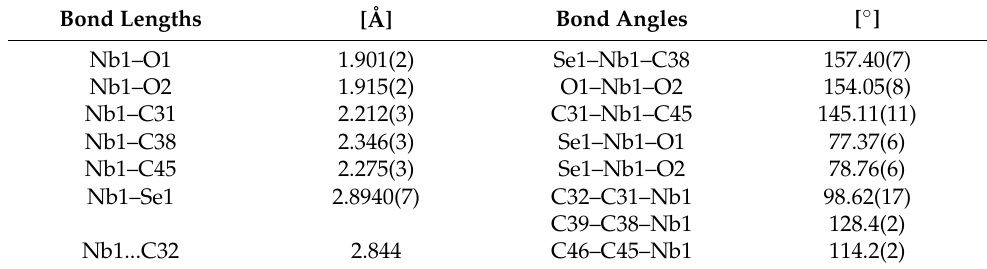
Figure 2. The ORTEP of mer - 6 with thermal ellipsoids at 50% probability. All hydrogen atoms and a molecule of hexane in the unit cell are omitted for clarity. Table 2. Selected bond lengths [Å] and bond angles [ ◦ ] of 6